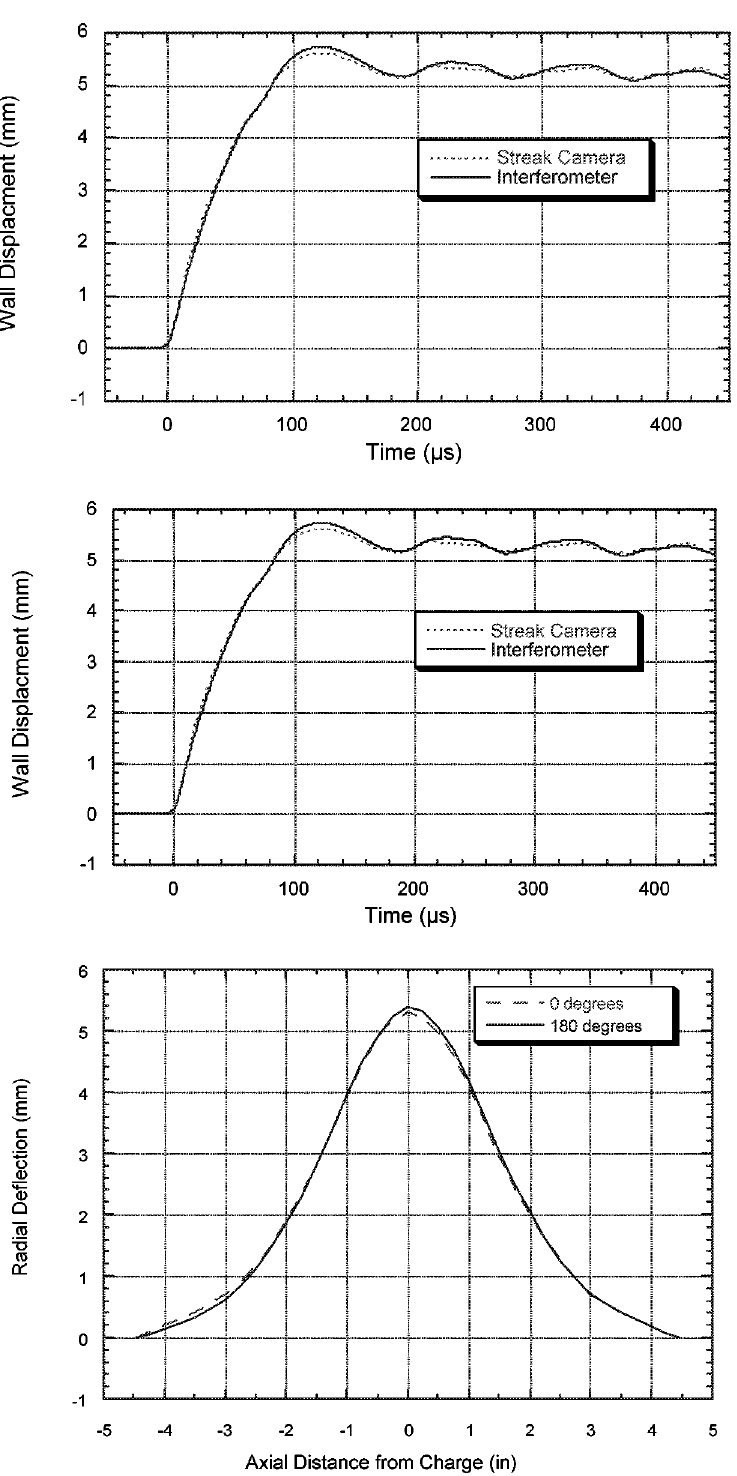
Fig. 3. Outside wall measurements from detonating a 3.0 g charge (Shot SV-3). (a)–(b) Dynamic responses at same tube height as center of charge; (c) Permanent